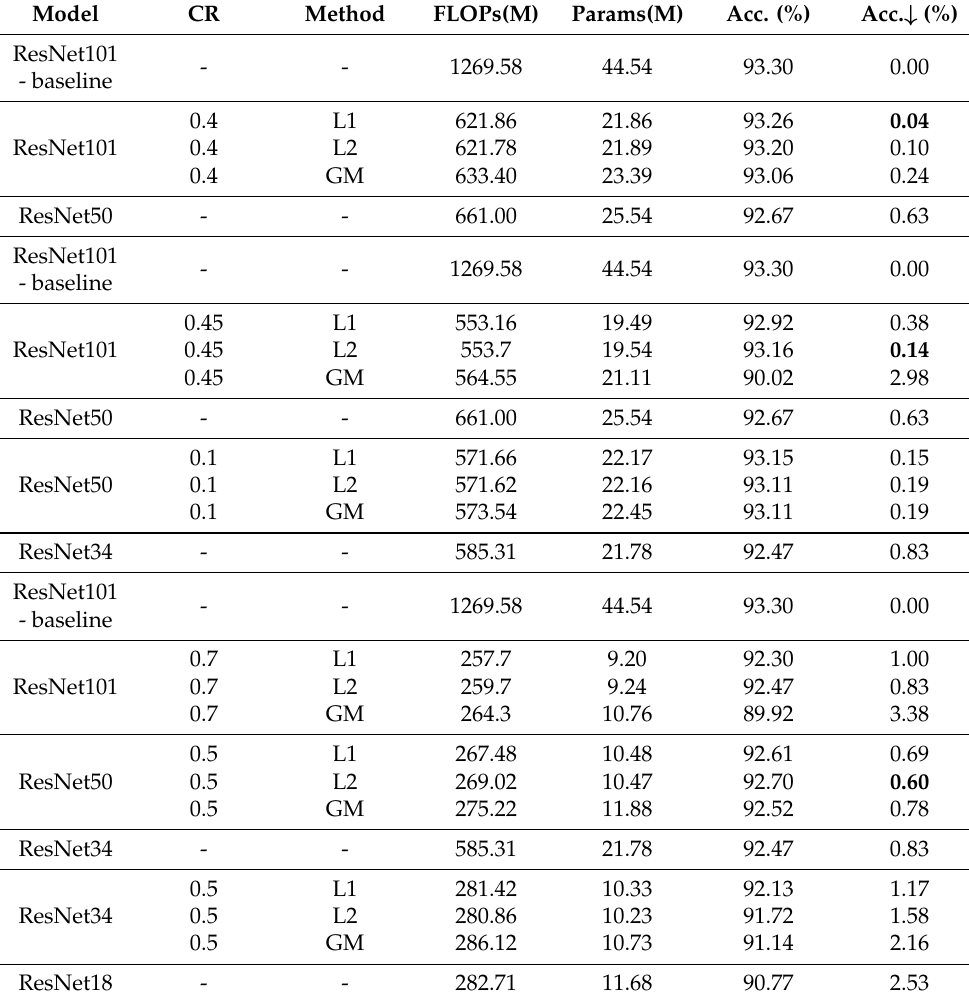
Table 2. Compression results of pruning ResNet on CIFAR-10. The “CR” column indicates the network compression ratio used for pruning, while “Method” denotes the network pruning criterion. In particular, the GM method denotes the criterion introduced in [19]. “Acc. ↓ (%)” is the accuracy drop from the baseline model, with smaller values being